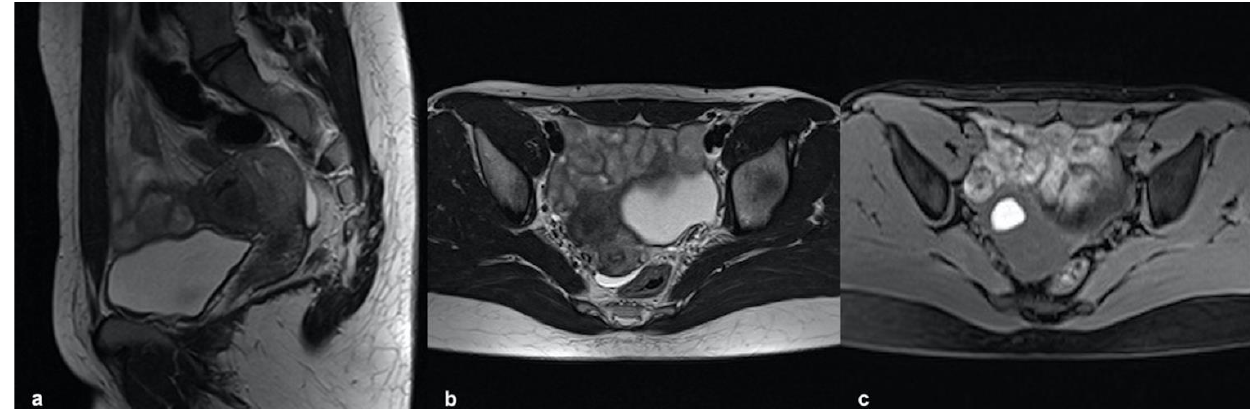
Figure 9. Intramural cystic adenomyoma: sagittal and axial T2-weighted images ( a , b ) showing a myometrial nodular mass with a central hyperintense cavity on T1-weighted images ( c ) due to the cavity ’s hemorrhagic content and without connection to the endometrial cavity.